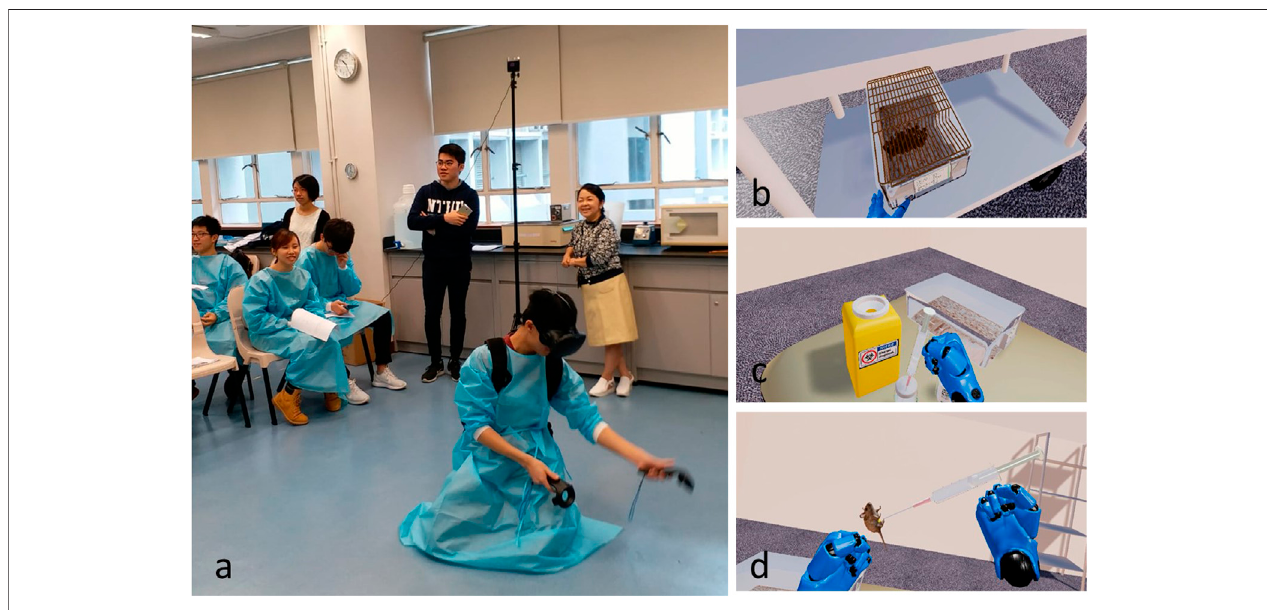
FIGURE 2 | The student player used the pair of the controllers for training the procedures of intraperitoneal injection to the mouse. The student player (A) concentrated onthegame; (B) locatedtheanimalcage onthe bench; (C) drew thedrugfrom thebottle, and (D) held themouse and performed intraperitoneal